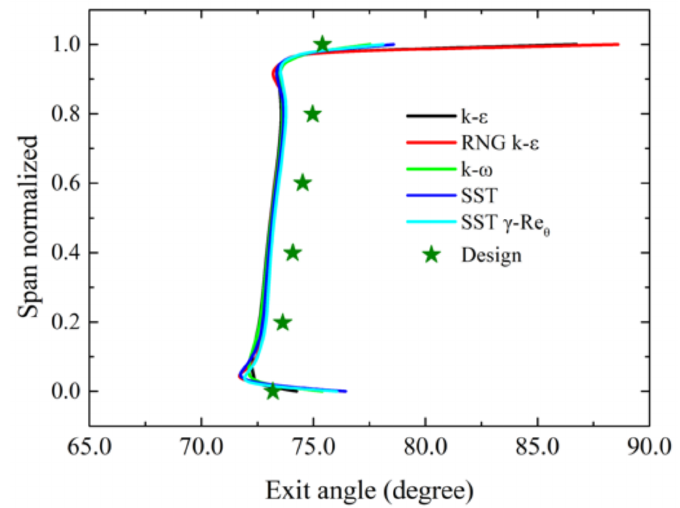
Figure 5. Circumferential averaged vane exit angle.